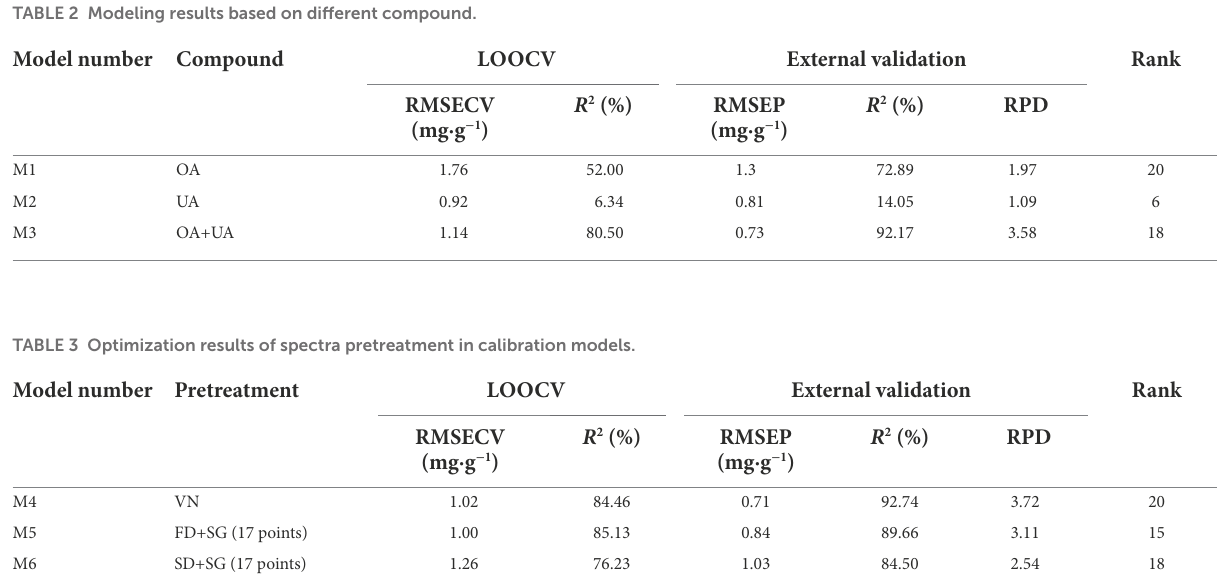
TABLE 2 Modeling results based on different compound.